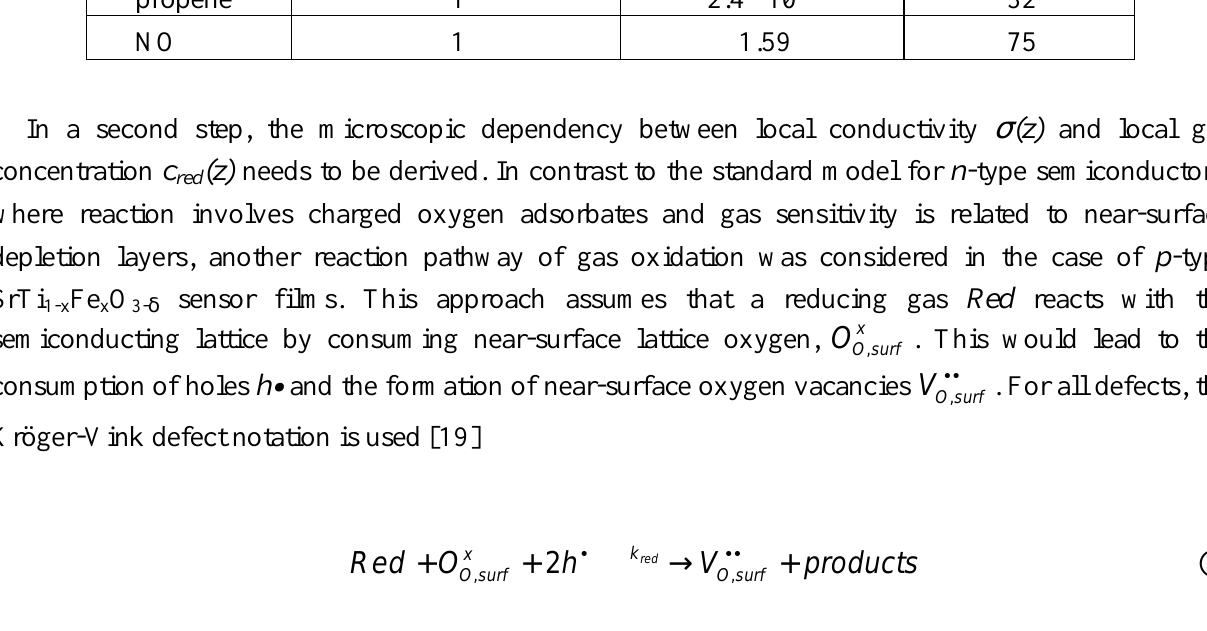
Fe O 0.8 0.2 3- d